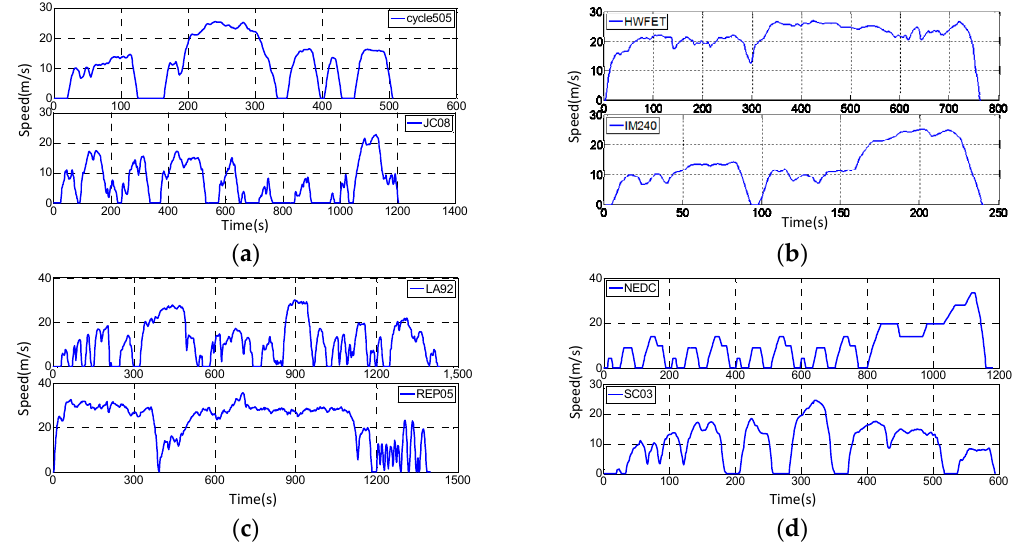
Figure 3. Drive cycle curves: ( a ) Cycle505 and JC08 cycles; ( b ) Highway Fuel Economy Test (HWFET) and IM240 cycles; ( c ) LA92 and REP05 cycles; and ( d ) New European Driving Cycle (NEDC) and SC03 cycles.